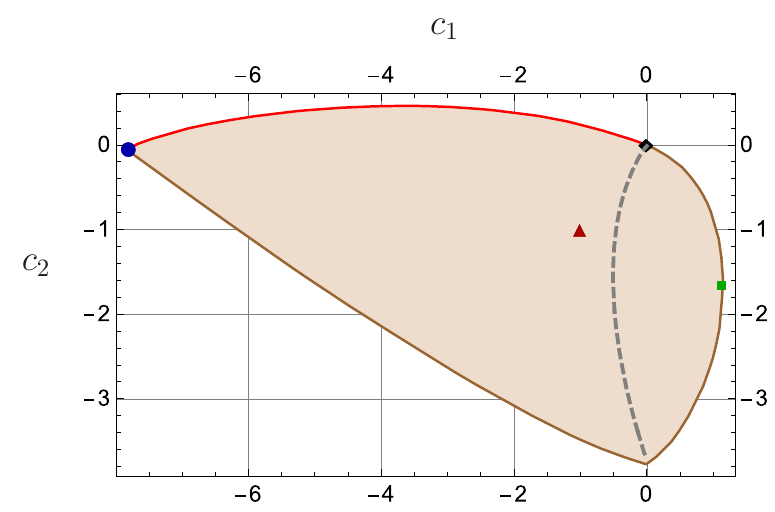
Figure 1 . Plot of the two-dimensional parameter space ( c 1 , c 2 ) of BPS solutions (shaded area) interpolating between the AdS 2 H 2 geometry in the IR and the DW 4 solution in the UV. ×